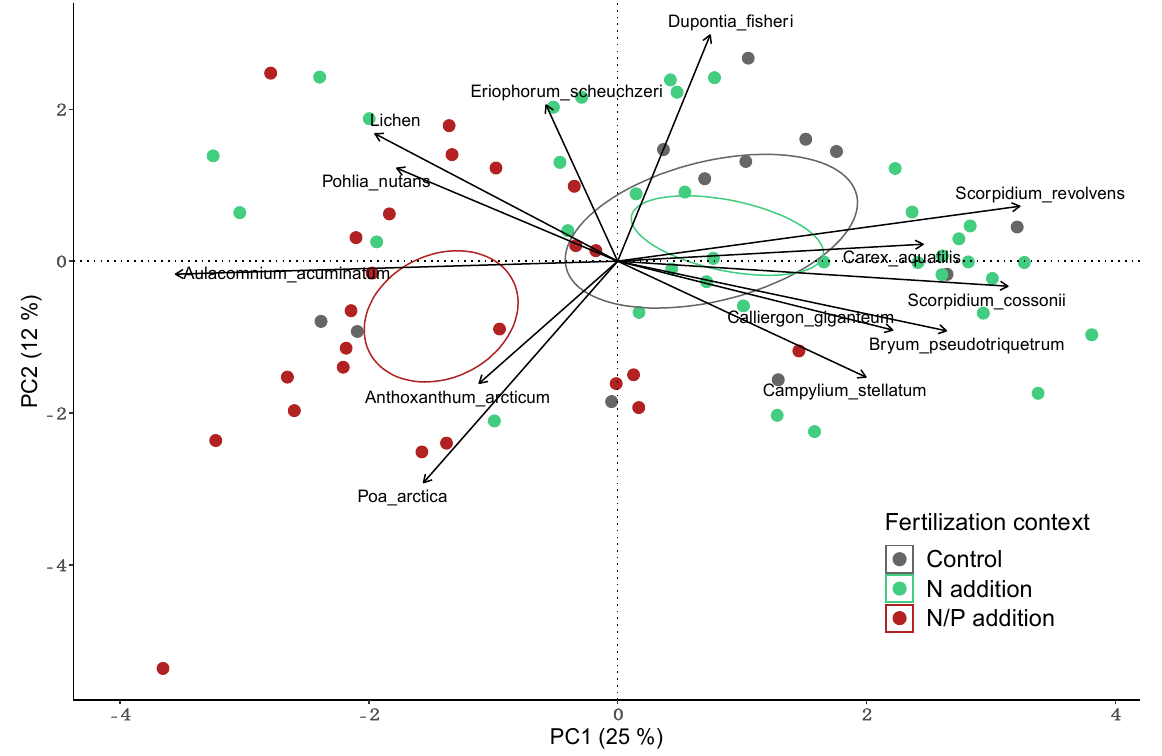
Figure 4. Results of the principal component analysis (PCA) on the plant composition of 72 plots with different fertilization treatments after 17 years of experimentation in tundra wetlands of Bylot Island, Nunavut. Arrows are the position of 13 plant species (seven bryophytes, five vascular plants and one lichen) most characteristic on each axis, and dots are the position of each sampled plot. The colored ellipses represent the confidence around the mean point (threshold of 0.95) of each fertilization context. The loading of plots analyzed and species contribution to the PCA are available in Tables A2 and A3, respectively.